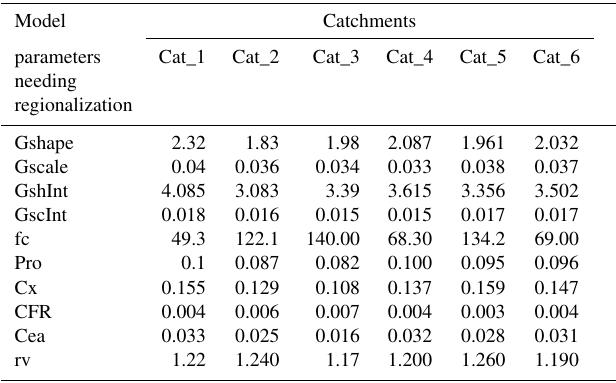
Table 3. Values of DDD model parameters estimated from region- alization for the study catchments.